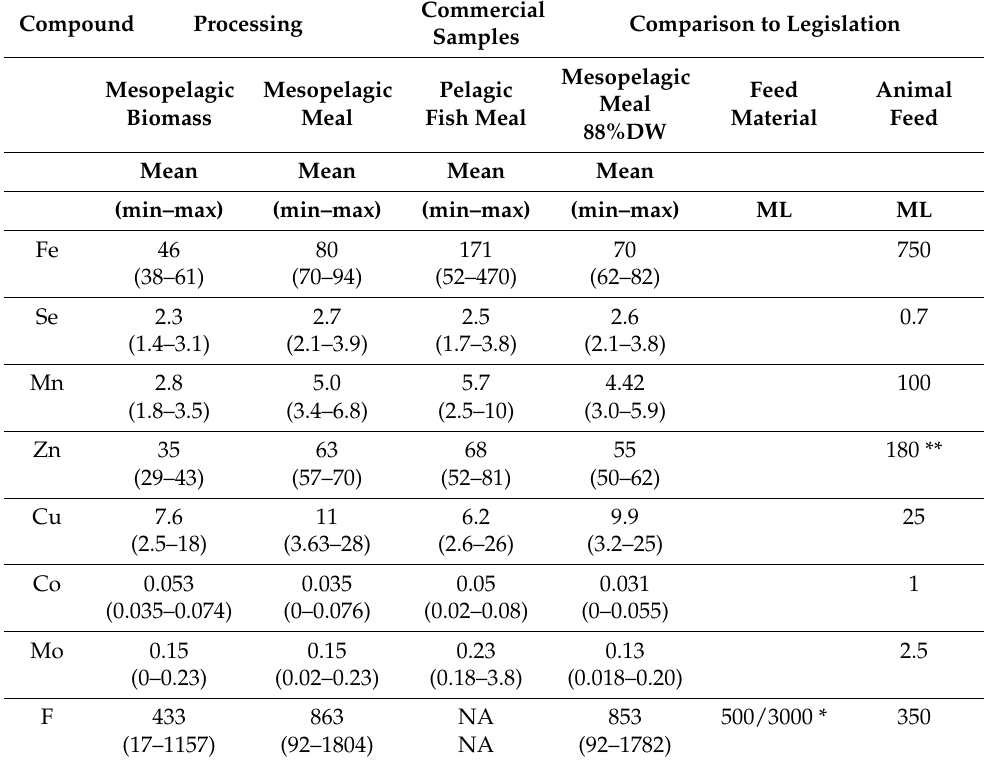
Table 1. Concentrations of the essential trace elements, iron (Fe), selenium (Se), manganese (Mn), zinc (Zn), copper (Cu), cobalt (Co), molybdenum (Mo), and fluoride (F) in mg kg − 1 dry weight (DW) (mean, (minimum-maximum), n = 4) in the raw mesopelagic biomass, the concentration in processed mesopelagic meal (DW), commercial pelagic fish meal from the monitoring program (n = 9), and mesopelagic meal expressed as 88% DW. For comparison, the maximum levels (ML) given in EU Directive 2002/32/EC and maximum content given in the Register of Feed additives ((EC) 1831/2003) are shown. * ML for marine crustaceans, ** feed for